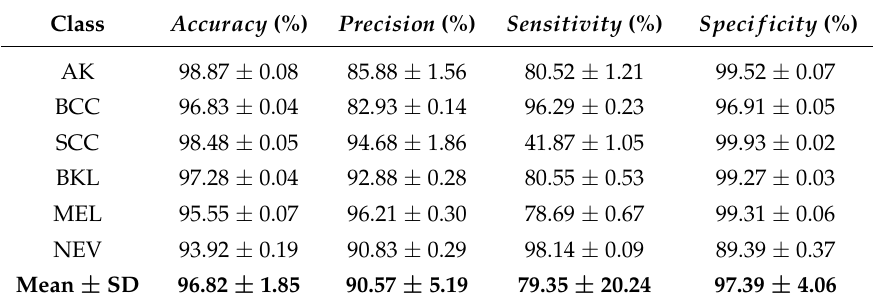
Table 8. Mean ± SD of five performance metrics for the training dataset of the Exp-4 with α = 1.6. The training dataset has 17,387 images.